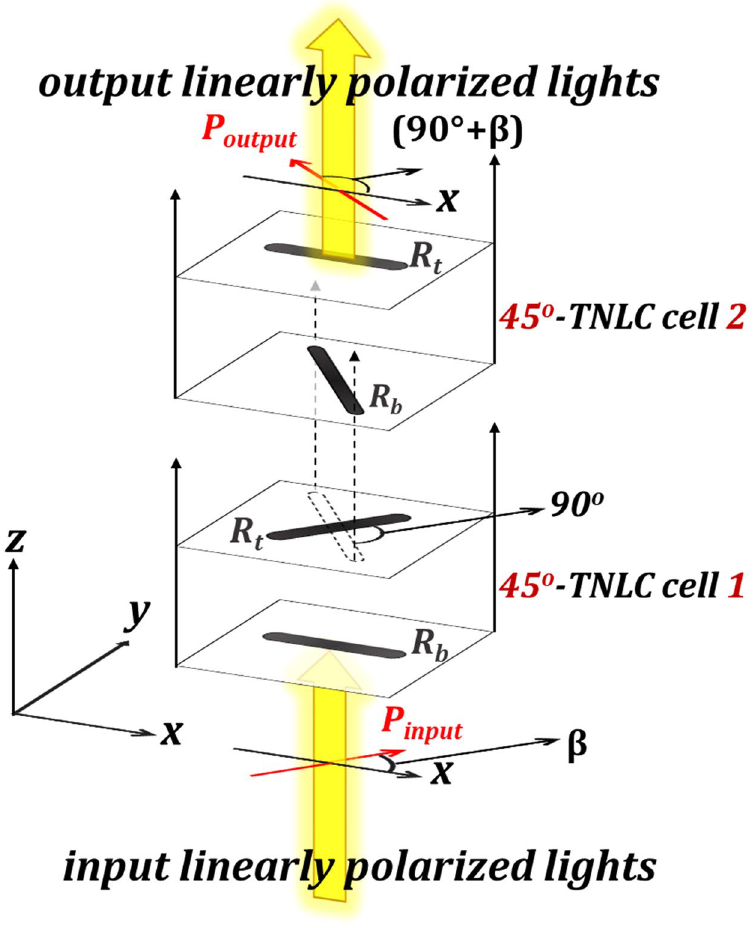
Figure 1. Schematic diagram of the arrangement of the tandem-90°-twisted nematic liquid crystal (TNLC) polarization